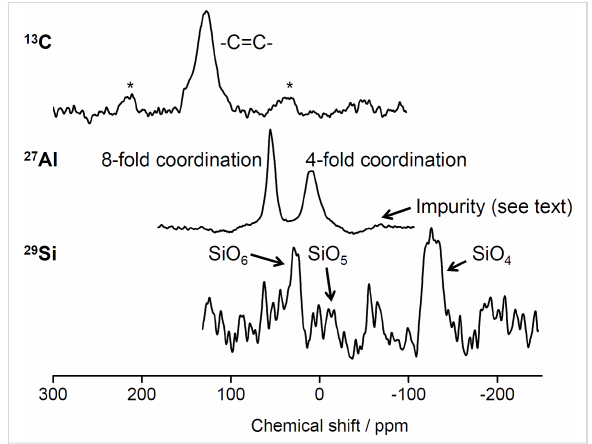
Figure 5: 29 Si, 27 Al and 13 C CP-MAS-NMR spectra of 2Z-HYCA calcined at 650 °C. * Rotation side bands of ethylene carbon.